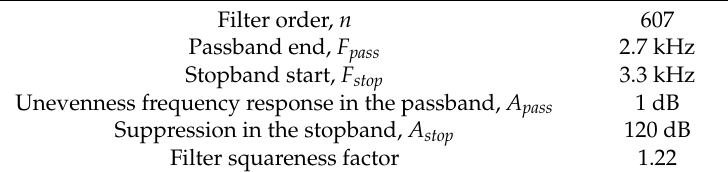
Table 8. The parameters of the test lowpass filter.